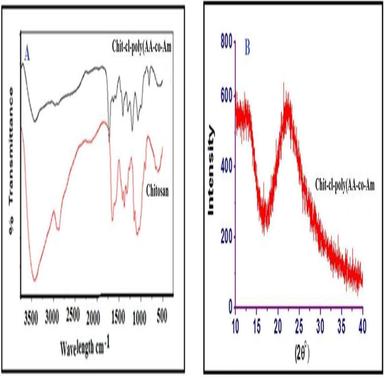
(A) FT-IR spectra of the chitosan and chit –cl- Poly (AA-co-Am) (B) XRD spectra of the chit-cl-Poly (AA-co-Am).